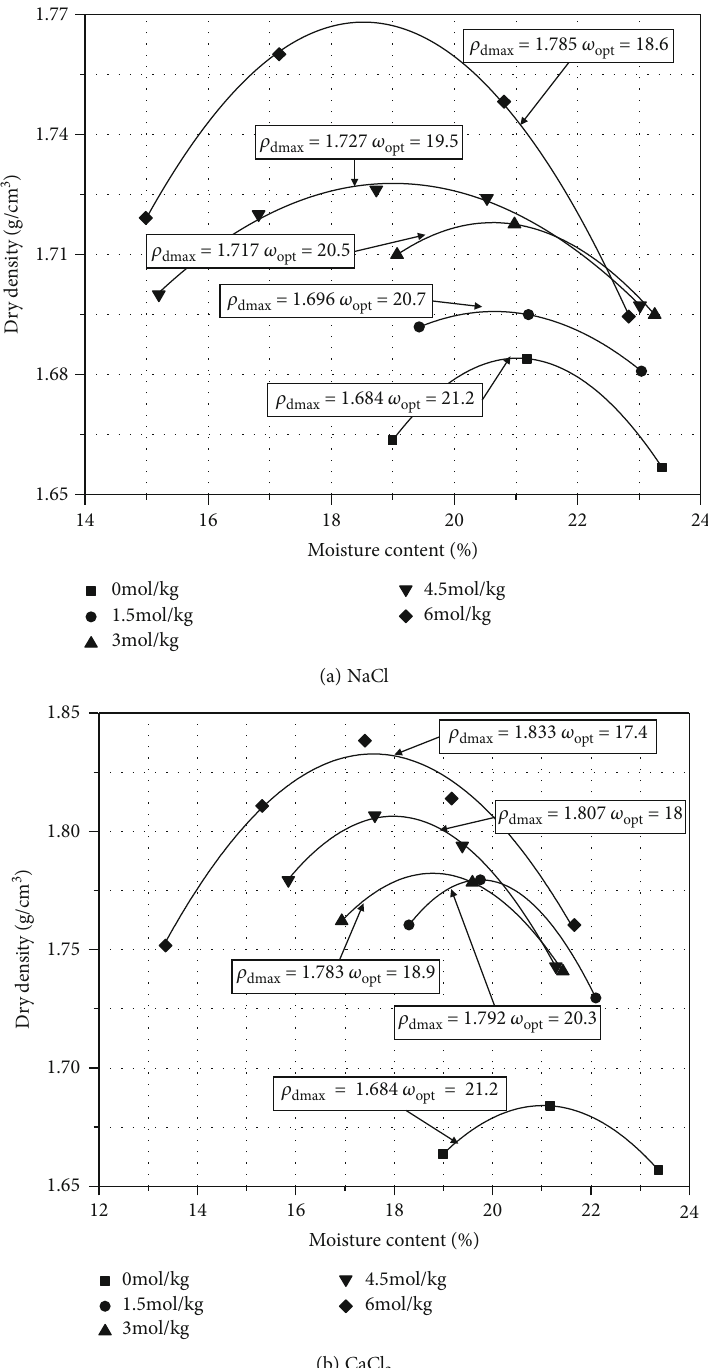
Figure 3: The compaction curves of saline soil with di ff erent concentrations of (a) NaCl and (b) CaCl % for ω opt